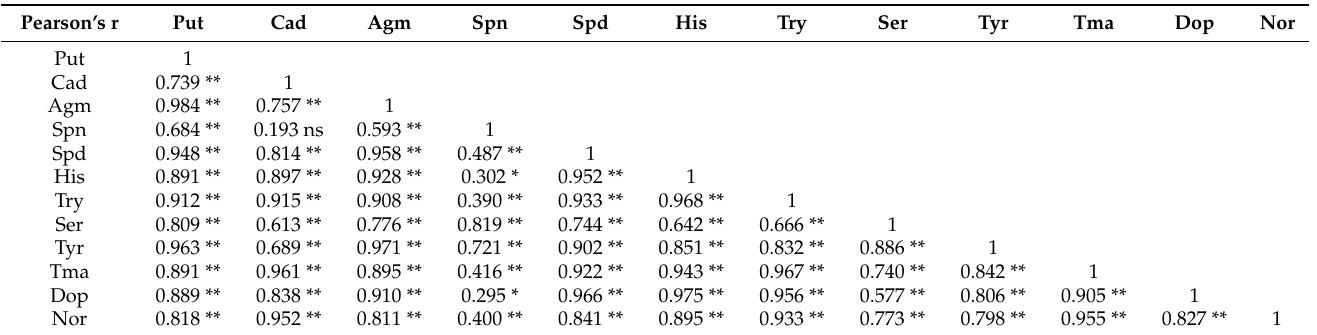
Figure 2. Grape varieties data correlation analysis. Scatterplot matrix representation for the entire data set belonging to biogenic amines values of grape varieties. Table 2. Pearson correlation between biogenic amines in grape varieties. Significant correlations are reported for 0.01 < p < 0.05 (**) and p < 0.01 (*). The color intensity is proportioned to the Pearson